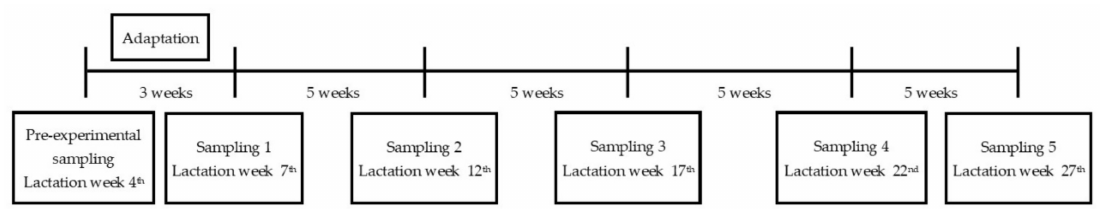
Figure 1. Chronogram of the